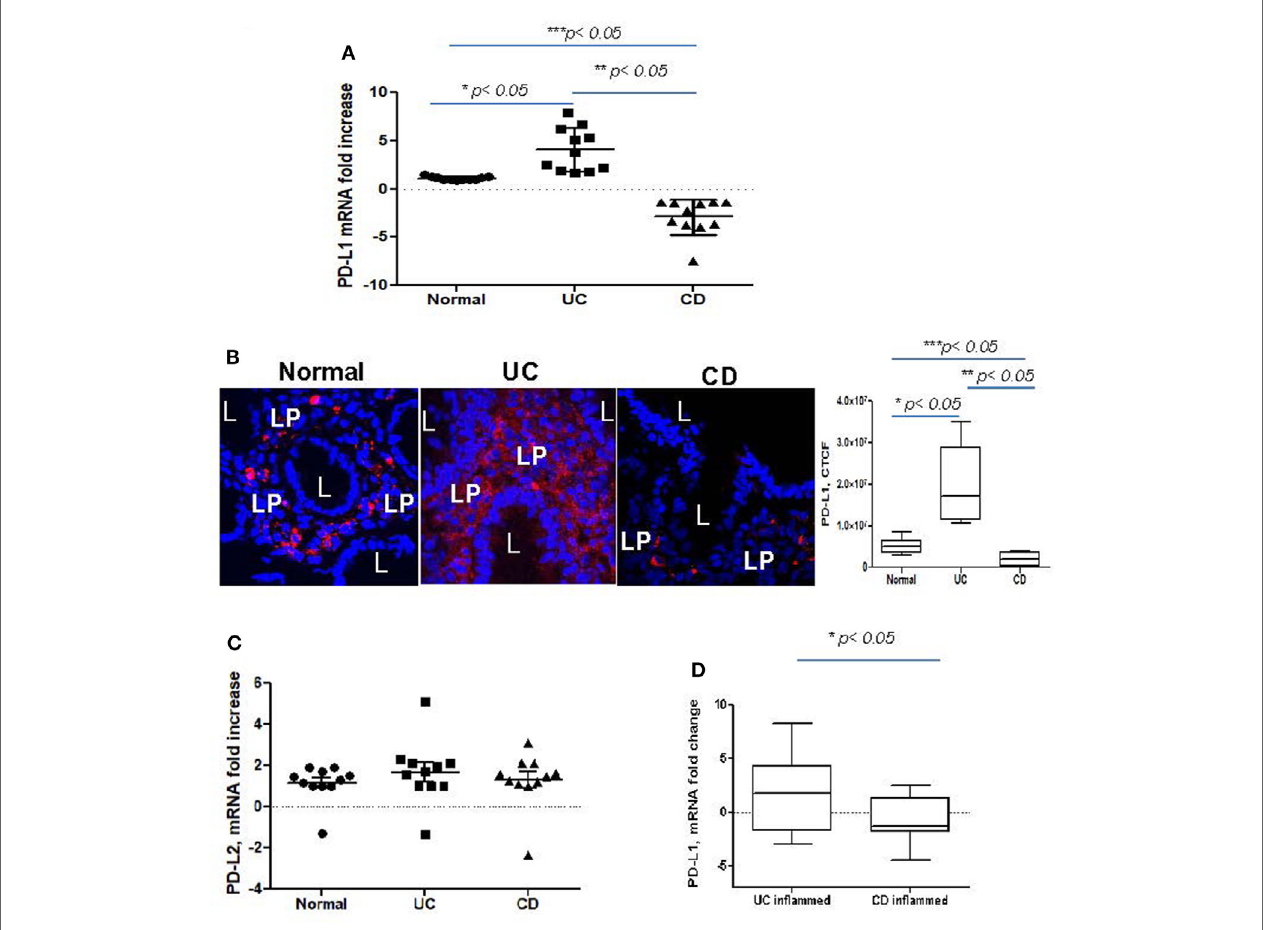
FigUre 1 | Programmed death-ligand 1 (PD-L1) is increased in ulcerative colitis (UC), but decreased in Crohn’s disease (CD) colonic mucosa. (a) PD-L1 mRNA levels in UC and CD colonic mucosa were compared to normal tissue controls obtained from healthy individuals (real-time RT-PCR analysis). The means ± SEM are shown as the results of duplicates of each tissue sample, n = 11 per group. (B) PD-L1 protein expression in situ was increased in UC and somewhat decreased in CD. In these experiments, frozen colonic tissue sections were stained with DAPI to identify cell nuclei (blue) and anti-PD-L1 monoclonal antibodies (clone MIH, in red) and analyzed by confocal microscopy (63 × ). A representative cross sections and summary of fold changes in the corrected total cell fluorescence (CTCF) of PD-L1 expression in UC, CD, and normal human colonic mucosa (the means ± SEM are shown, n = 10 per group) are shown, L, lumen; LP, lamina propria, * p < 0.05 . (c) PD-L2 mRNA levels in UC and CD colonic mucosa were compared to normal tissue controls obtained (real-time RT-PCR analysis). The means ± SEM shown are the results of duplicates of each tissue sample, n = 11 per group. (D) PD-L1 mRNA levels in UC and CD inflamed colonic mucosa was normalized to